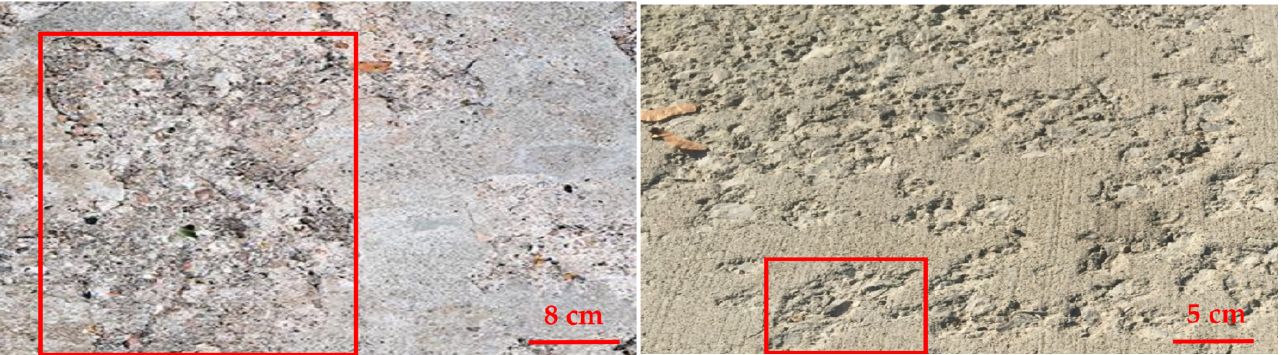
Figure 5. Sample images of spalling defects in concrete with scale bar.